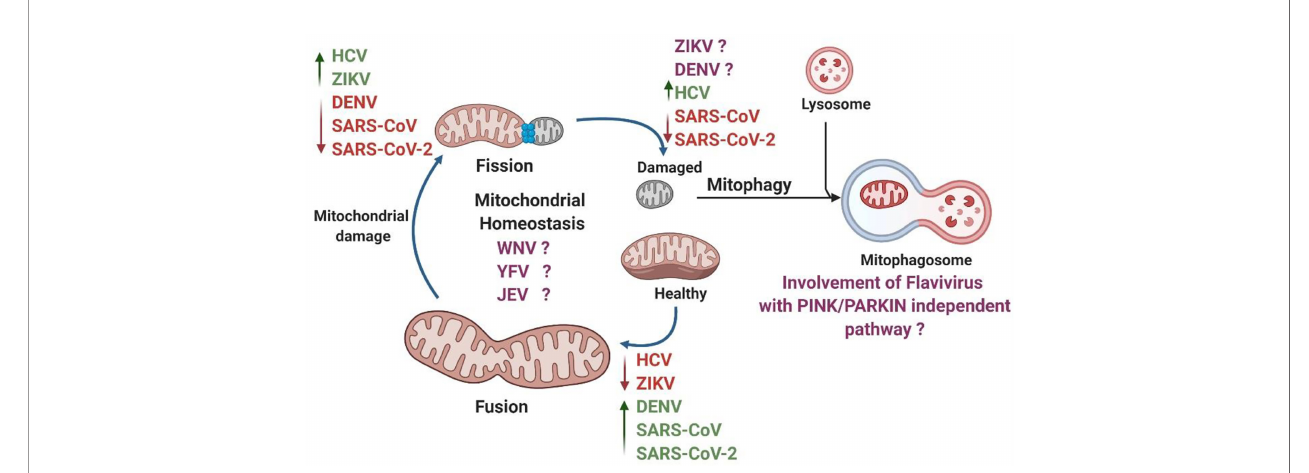
FIGURE 5 | Summary of RNA viruses impacting various processes of mitochondrial dynamics. Under static conditions, the mitochondria exist in a tubular network. However, physiological stress and viral infection can cause damage to the mitochondria. The damaged mitochondria undergo fi ssion and recycled via mitophagy. The remaining functional tubules rejoin the mitochondrial network through the fusion process. Viruses can hijack these processes to aid in their replication. Individual RNA viruses are shown to increase (in green) or decrease (in red) mitochondrial dynamics. There are many fl avivirus with unknown effects on mitochondria (in purple).